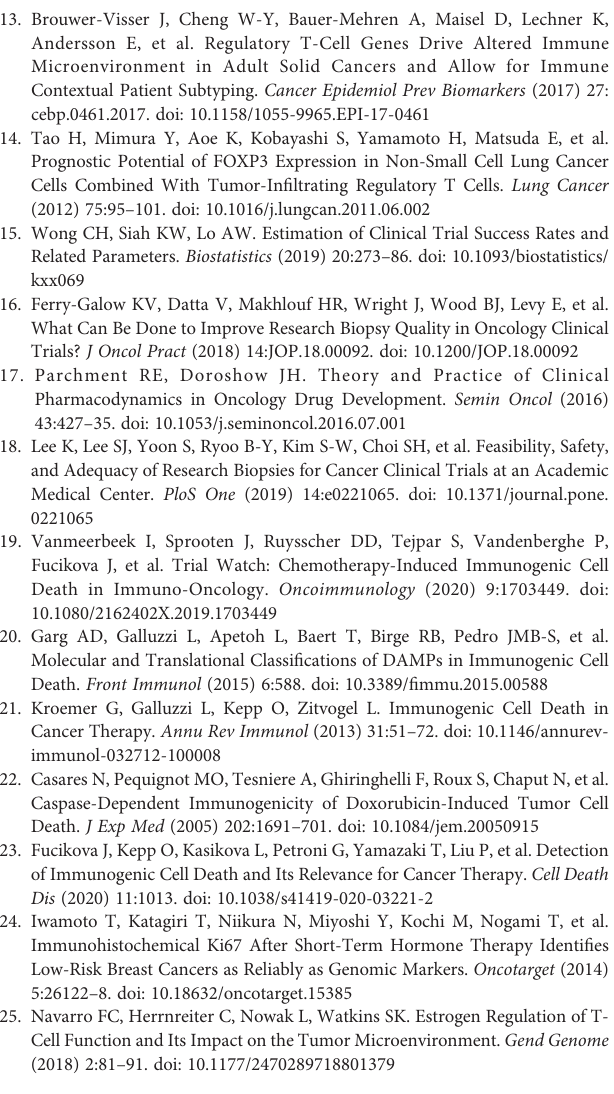
Supplementary Table 1 | Invidumed Samples Patient Characteristics. All Invidumed samples were commercially available, untreated primary samples from resected tissue. Supplementary Table 2 | FoxP3+ Univariateand MultivariateRegression Analysis. The association between FoxP3+ cells/mm 2 in tumor biopsies and each variable of interest was determined in a linear mixed effect model using restricted maximum likelihood estimation (A) . Variables with a p-value ≤ 0.1 or an effect size of >2 or <0.5